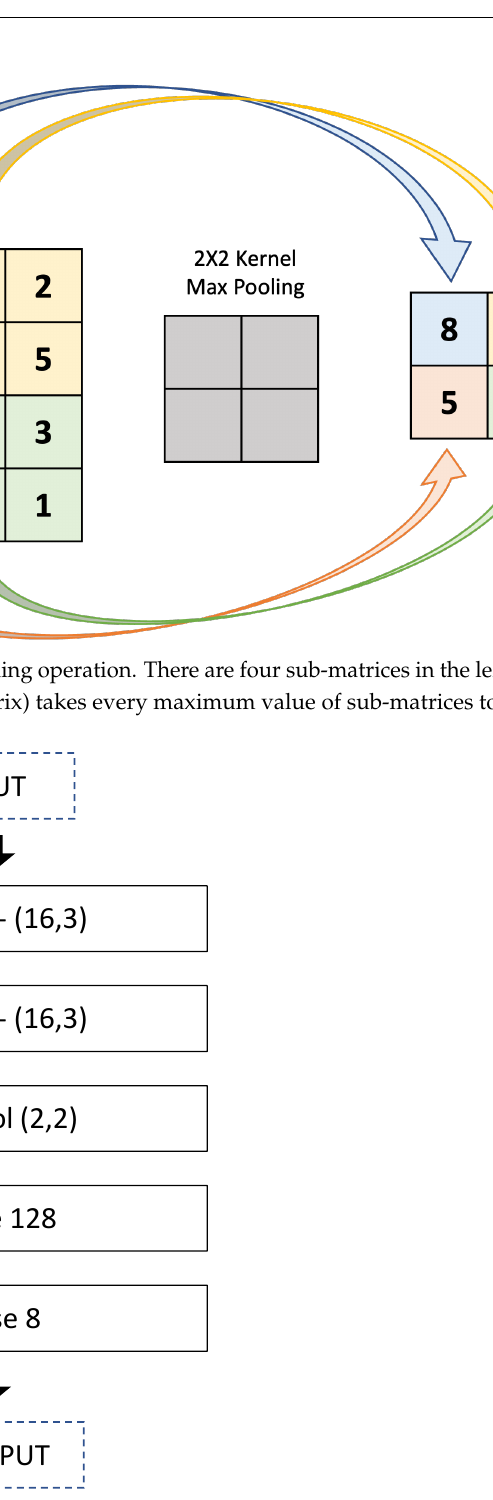
Figure 5. The construction of GAF-CNN